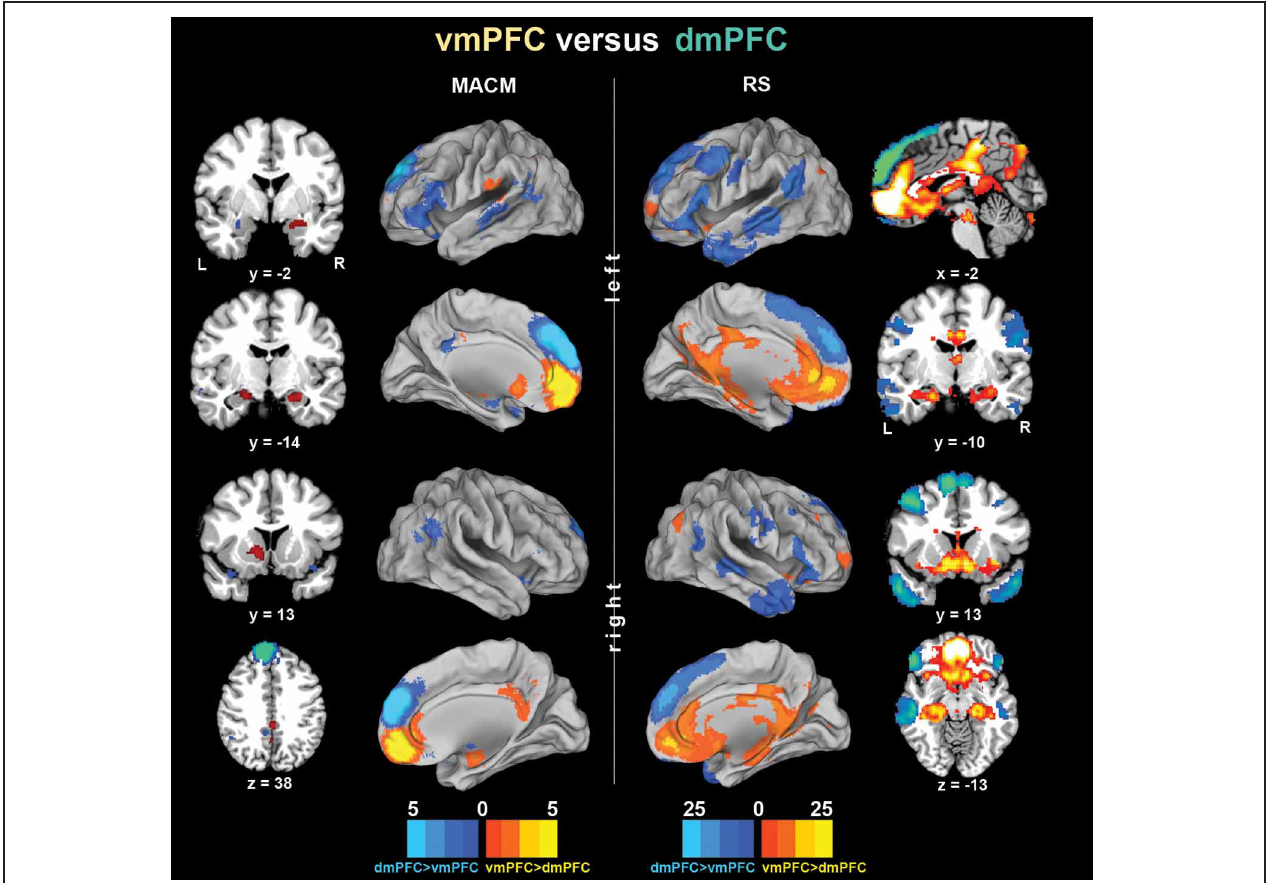
FIGURE 3 | Functional connectivity differences between the vmPFC and dmPFC seeds. Connectivity differences between the seeds individually determined using meta-analytic connectivity modeling (MACM)